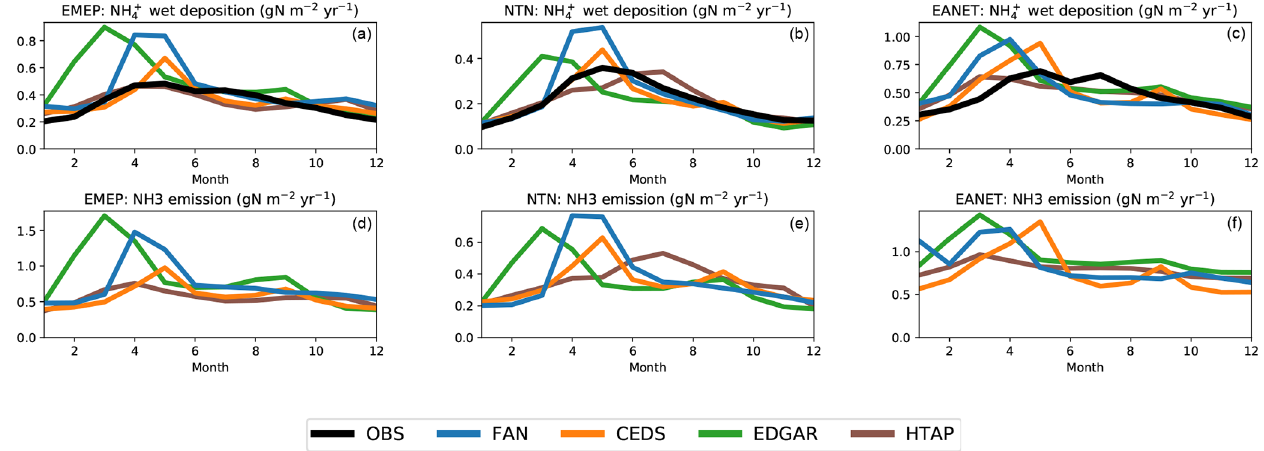
+ wet deposition (a–c) and and NH 3 emissions for the EANET, EMEP and NTN networks. All Figure 8. Seasonal profiles of simulated NH 4 values are averaged over the years 2010–2015; the emission fluxes are evaluated for the observed